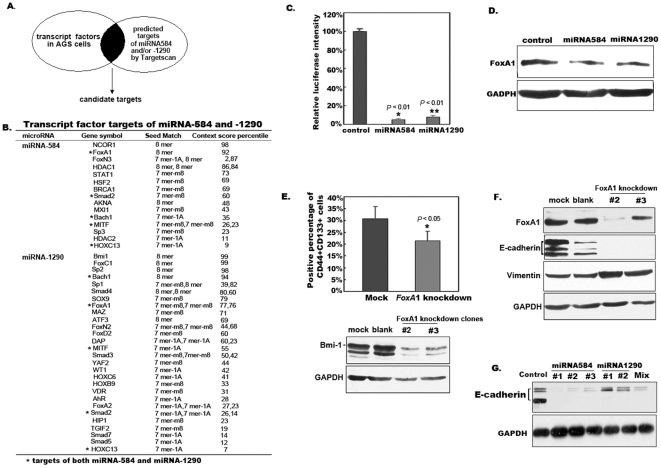

Foxa1 is a target of miRNA-584 and miRNA-1290 and knockdown of Foxa1 promotes EMT. A. Schematic of potential target screening strategy. B. Transcription factor targets of miRNA-584 and miRNA-1290.Transcription factors targeted by miRNA-584 and miRNA-1290 expressed in AGS cells were predicted by TargetScan (www. targetscan.org). C. Determination of pMIR-report luciferase activity. The recombinant plasmid pMIR-Foxa1 report was co-transfected with pcDNA6.2-GW/EmGFP-miR containing miRNA-584 or miRNA-1290 into AGS gastric cancer cells for 48 h. Cells were lysed and luciferase activity was determined by dual-luminescence reporter assay. Co-transfection of miRNA-584 or miRNA-1290 with pMIR-Foxa1 inhibited more than 90% of firefly luciferase activity (all P <0.001, ANOVA), indicating that miRNA-584 and miRNA-1290 target Foxa1 mRNA. D. Detection of Foxa1 in cells transiently expressing miRNA-584 and miRNA-1290. pcDNA6.2-GW/EmGFP-miR containing miRNA-584 or miRNA -1290 was transfected into SW620 colon cancer cells for 48 h. Cells (1×106) were lysed and the supernatant was subjected to western blot analysis. The results showed that the expression of Foxa1 protein was down-regulated about 50% after transfection of miRNA-584 or miRNA-1290. These results indicate that Foxa1 is a target of miRNA-584 and miRNA-1290. E. Analysis of the percentage of CD44+CD133+ cells. SW620 colon cancer cells were infected with recombinant Foxa1 shRNA lentivirus. Infected SW620 cells were digested and resuspended at 1×106 per 100 µL of PBS containing 2% FBS, and labeling antibodies (APC-CD44 and PE-CD133) were added at 4°C for 30 min in the dark. After two washes, cells were analyzed using a FACSAria. An empty vector control was also established. The percentage of CD44+CD133+ cells significantly decreased after Foxa1 knockdown (P <0.05, ANOVA). The supernatant from SW620 colon cancer cells with Foxa1 knockdown was subjected to western blot for detection of Bmi1. F.
Foxa
1 knockdown promotes EMT. The supernatant from SW620 colon cancer cells with Foxa1 knockdown was subjected to SDS-PAGE, and proteins were transferred onto a nitrocellulose membrane for western blotting for Foxa1, E-cadherin, and vimentin. G. Detection of E-cadherin in cells with stable expression of miRNA-584 or/and miRNA-1290. pcDNA6.2-GW/EmGFP-miR containing miRNA-584 or/and miRNA -1290 was transfected into SW620 colon cancer cells. Cells were separated at 24 h after transfection and screened by 5 µg/mL puromycin for 7 days. Survival clones were picked up and amplified respectively for 4 weeks. Cells were lysed and the supernatant was detected for E-cadherin. GAPDH was as controls.